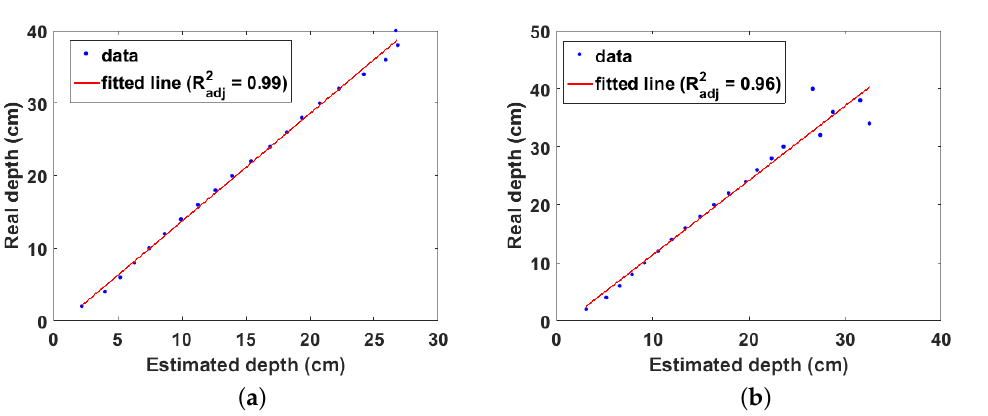
Figure 11. ( a ) linear fit of estimated and real depth for Co-60 buried in concrete of density = 2.18 g cm − 3 ; ( b ) linear fit of estimated and real depth for Co-60 buried in concrete of density = 3.35 g cm − 3 .